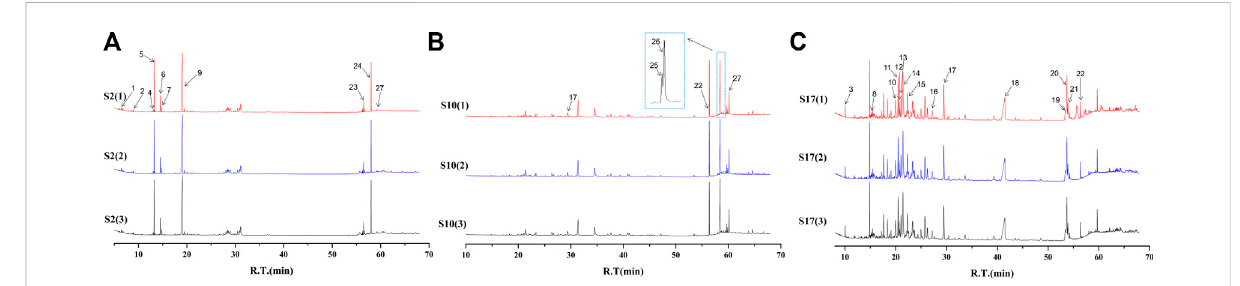
FIGURE 2 GC-MSchromatogramsofrepresentativeAEOsamples: (A) S2(adulteratedsample), (B) S10(extractedbySFE), (C) S17(extractedbySDE).(1) – (3) represents the GC-MS chromatograms of the same AEO sample, and three times GC-MS analysis were carried out to show the repeatability. The 26 components identi fi ed are numbered in the fi gure, which matches the serial numbers of each component in Table 2.